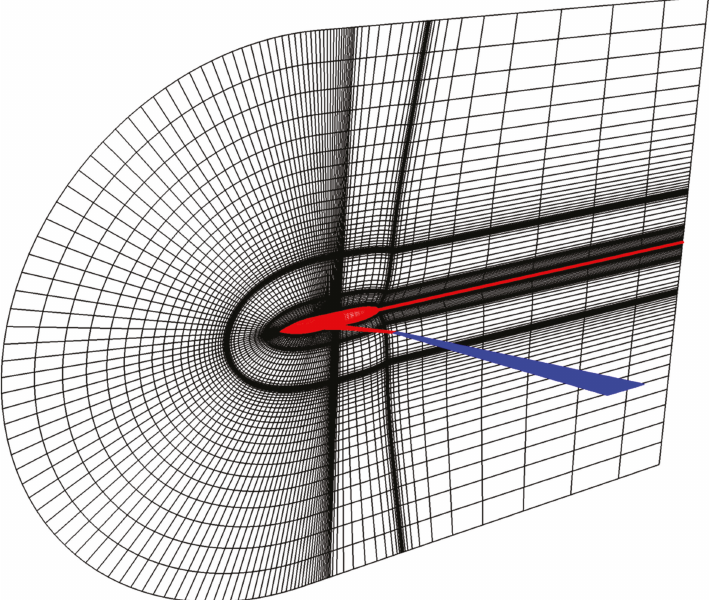
Figure 22: A C-H mesh having dimensions ( 165 × 50 × 85 ) showing the re fl ection plane version of the ARA M100 wing-fuselage